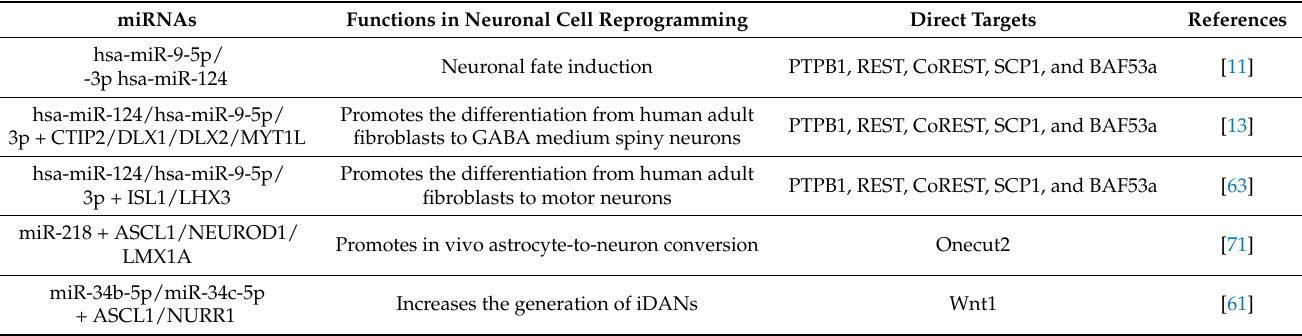
Table 2. Summary of the main miRNAs discussed in the text with their known functions in direct neuronal